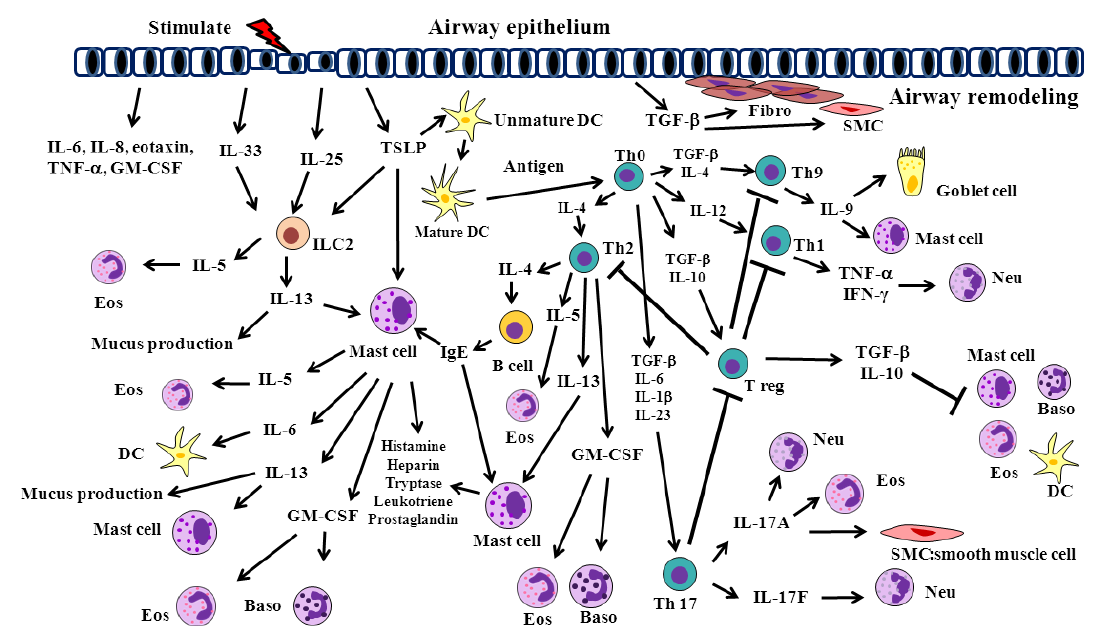
Figure 1. Cytokine profiles in the development of asthma.